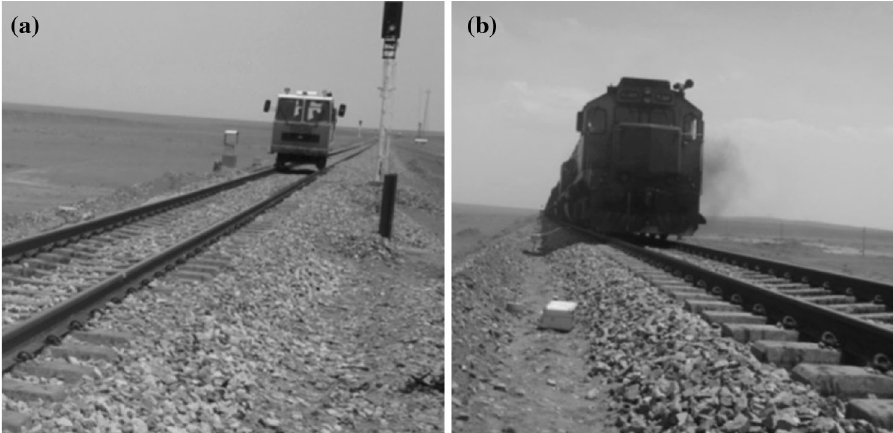
Fig. 3 Vibration excitation methods: a the draisine, b the freight